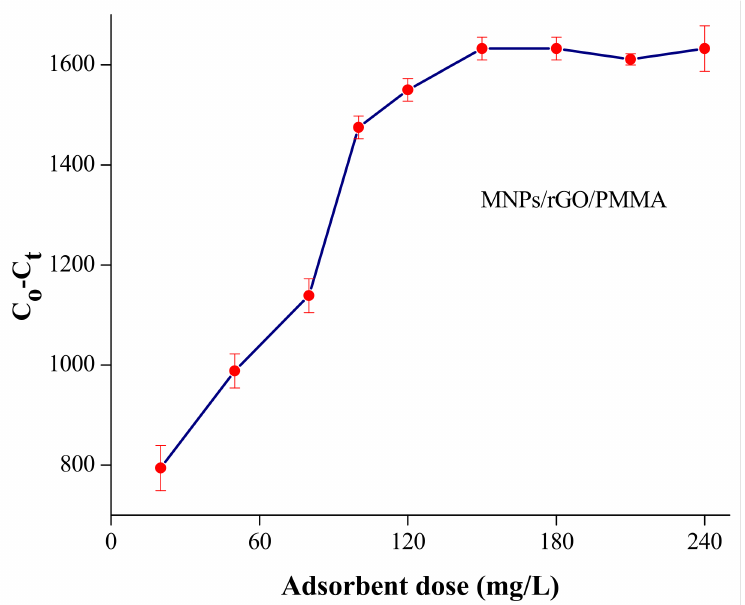
Figure 5. Effect of adsorbent amount on adsorption of Cr(VI) on MNPs/rGO/PMMA composite; pH 2; sample volume, 10 mL; shaking time, 30